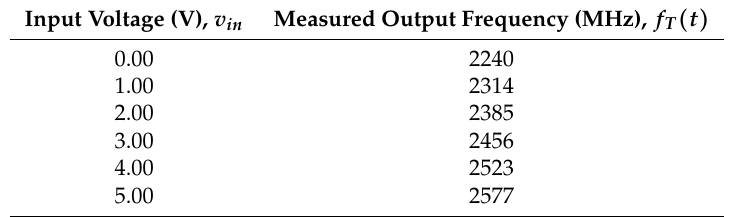
Table 2. Input voltage and measured output frequency table for the 2.4 GHz VCO